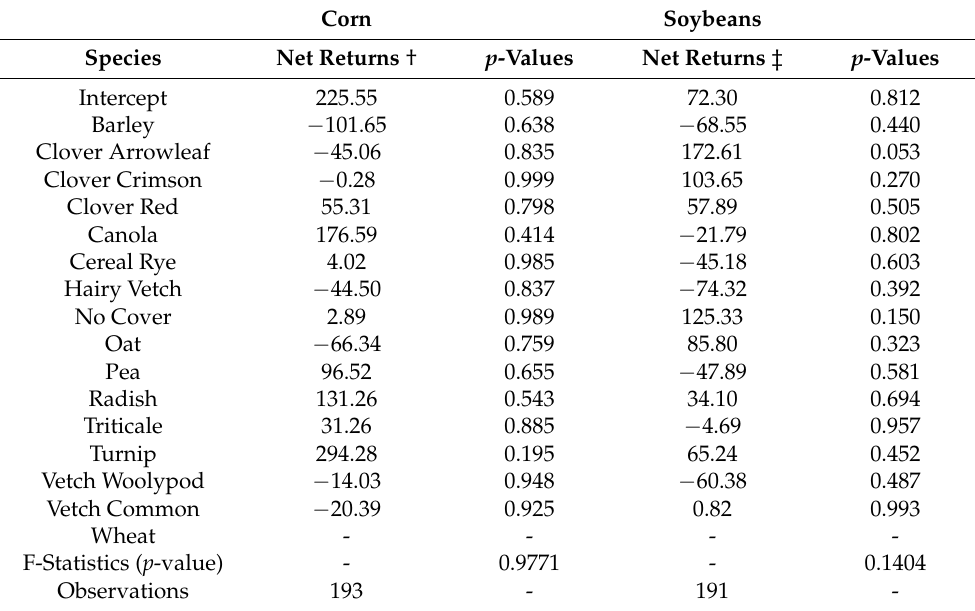
Table 4. Parameter estimates from corn and soybean ANOVA analysis across cover crop